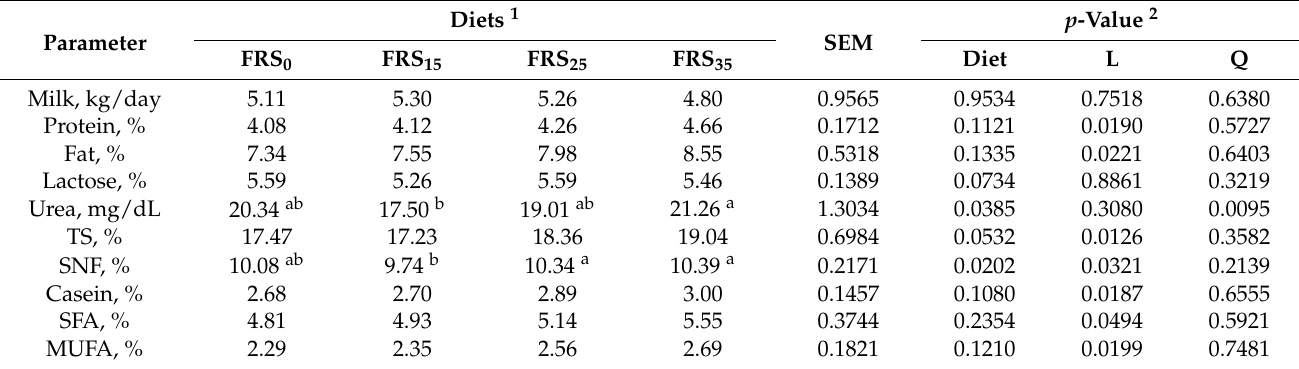
Table 5. Milk yield and milk composition in lactating buffaloes fed the four experimental